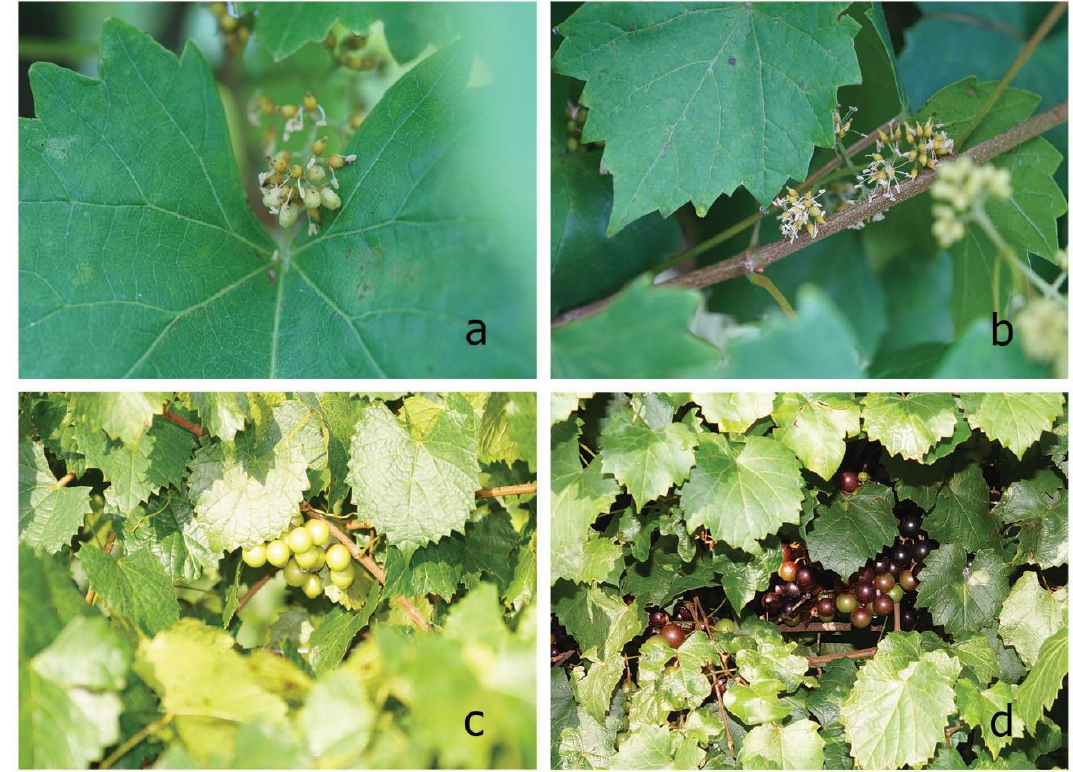
Figure 1. Flowers ( a ) and ripe berries ( c ) of yellow M. rotundifolia (Michx.) Small. cultivar “Carlos”, and flowers ( b ) and ripe berries ( d ) of red M. rotundifolia (Michx.) Small. cultivar “Noble” .